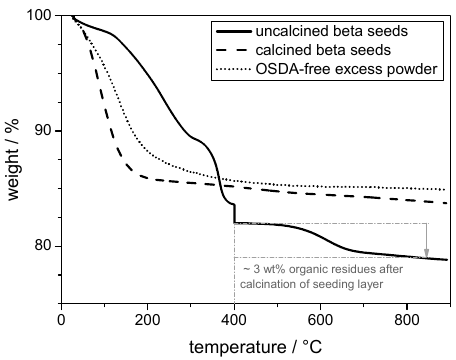
Figure 3. TGA curves of beta seeds calcined at 550 °C (prepared with OSDA), the OSDA-free excess powder formed during the secondary growth step, and simulated calcination process at 400 °C of non-calcined beta seeds as it was used for the calcination of the seed layers.